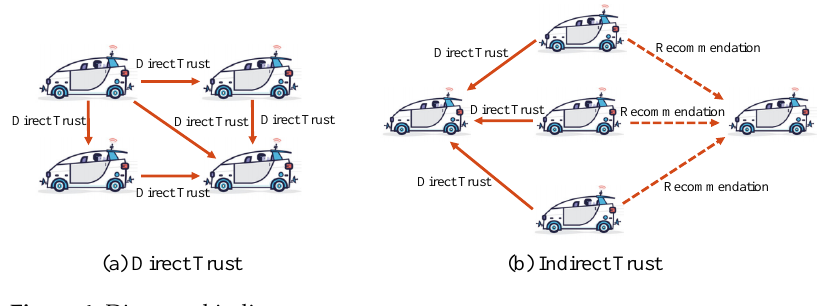
Figure 4. Direct and indirect